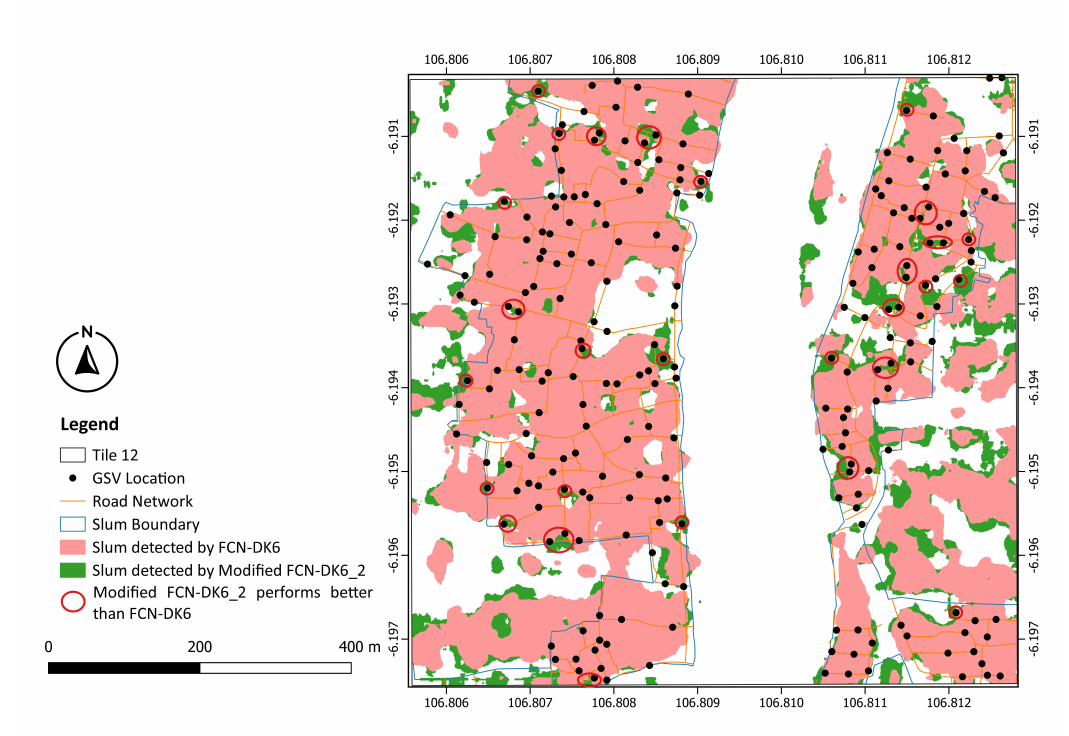
Figure 12. The outcome generated by Modified FCN-DK6_2 and FCN-DK6 for tile-12 (location highlighted by red circle represent those places where Modified FCN-DK6_2 perform better than FCN-DK6_2 because of the availability of GSV location).